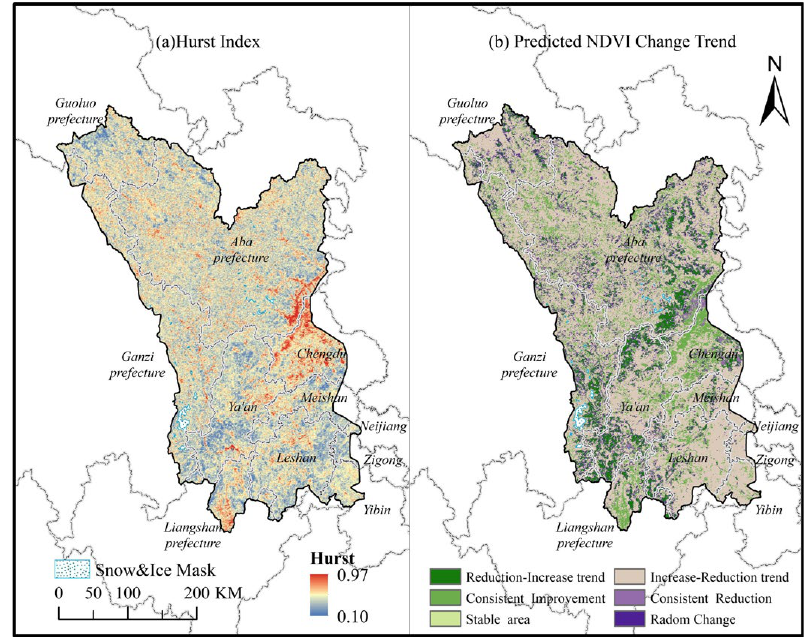
Figure 5. Hurst index of average NDVI and spatial distribution map of change sustainability in the Minjiang River